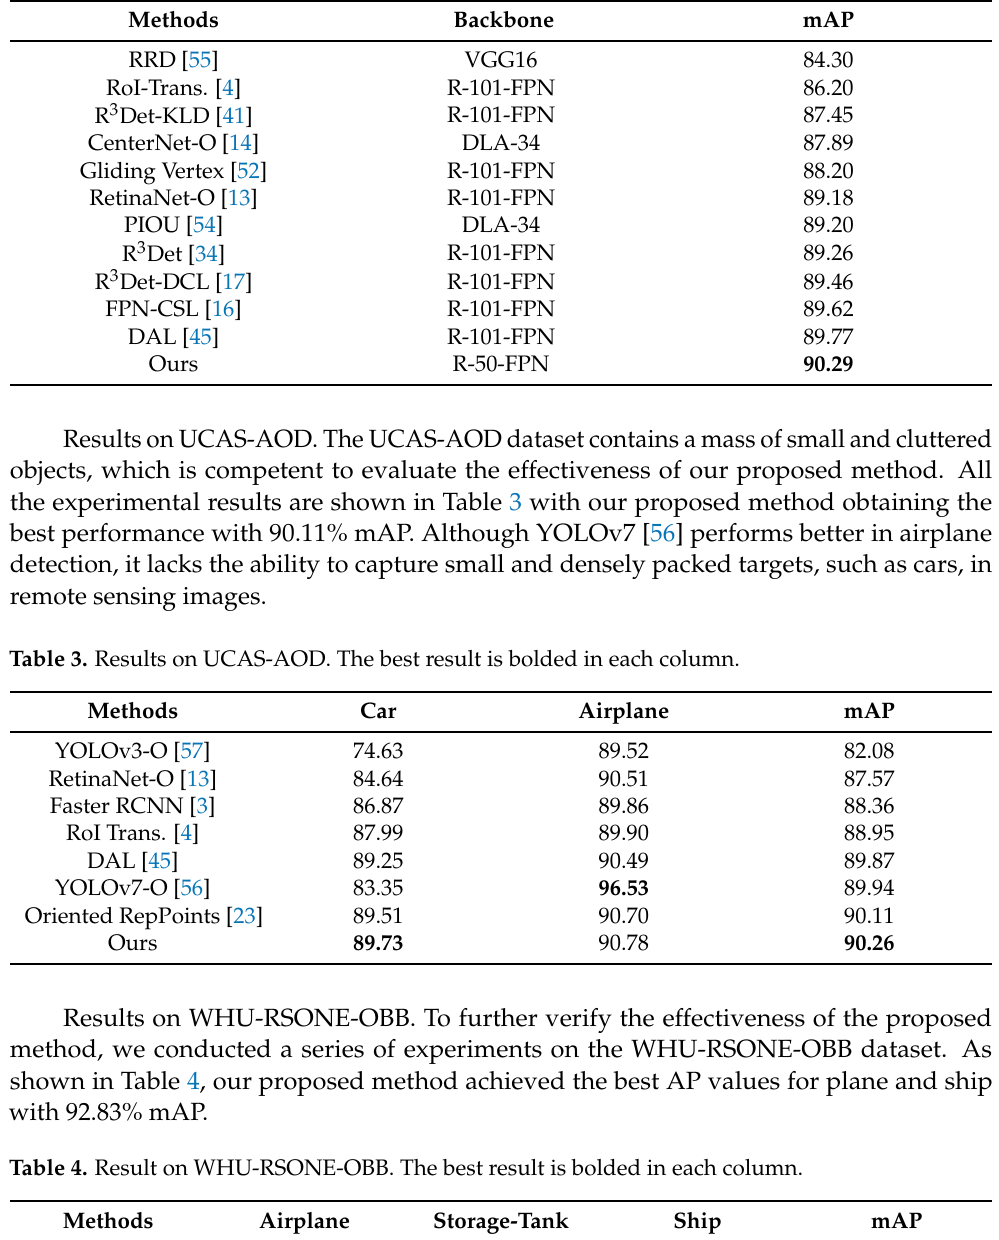
Table 2. Results on HRSC2016. The best result is bolded.